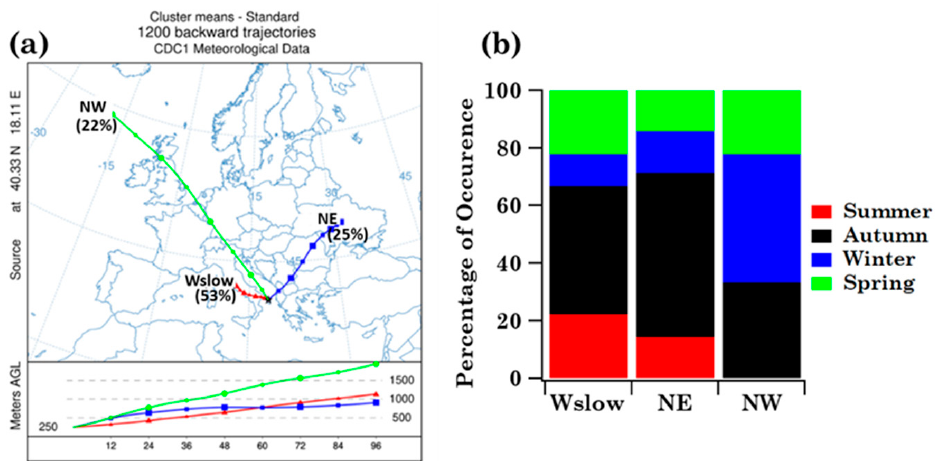
Figure 12. ( a ) Centroids associated with the main airflow types calculated by the cluster analysis of the four-day analytical back-trajectories that reached Lecce at 250 m AGL throughout the sampling period and ( b ) corresponding airflow frequency of occurrence in summer, autumn, winter, and spring in Lecce.